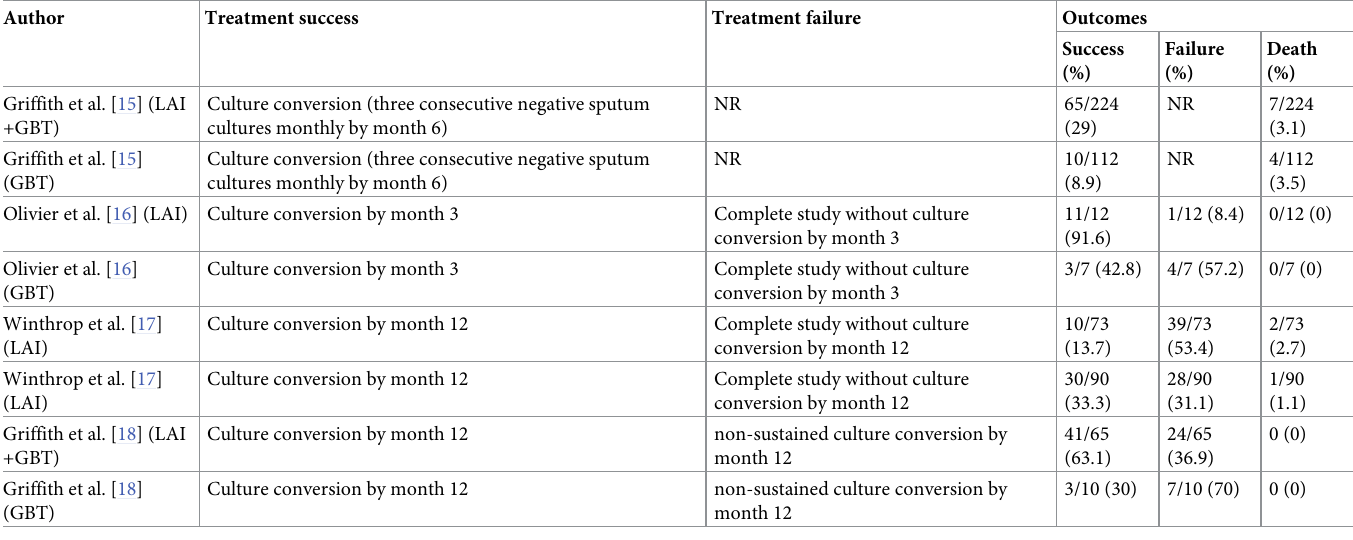
Table 5. Treatment success, failure and outcomes of